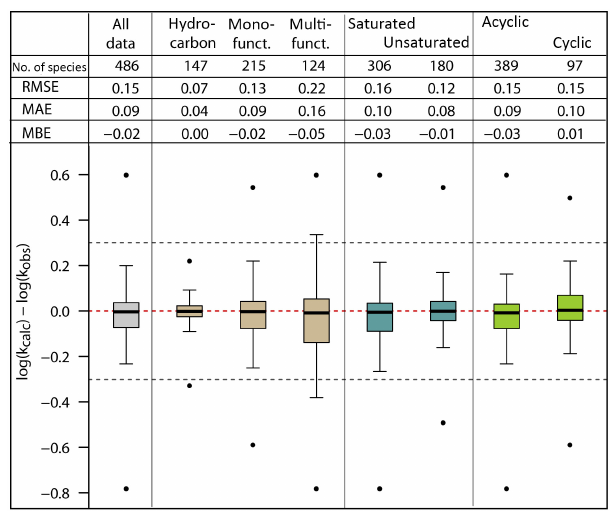
Figure 11. Root mean square error, mean absolute error, mean bias error and box plot for the error distribution in the estimated log k 298K values for the full set and various subsets of aliphatic species in the database. The bottom and the top of the box are the 25th ( Q 1 ) and 75th percentiles ( Q 3 ), the black band is the median value. The whiskers extend to the most extreme data point which is no more than 1.5 × ( Q 3 – Q 1 ) from the box. The points are the extrema of the distribution. The black dotted lines correspond to agreement within a factor